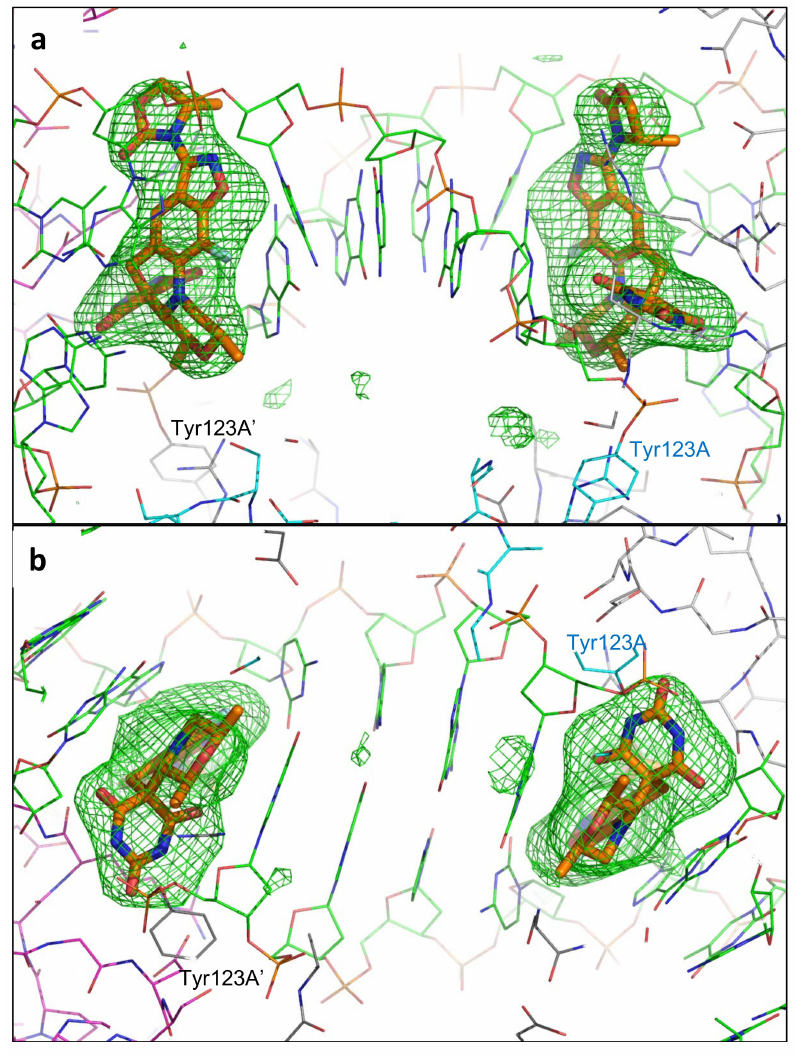
Figure 2. Final Fo-Fc omit map (+3 sigma) for the two zoliflodacins: orthogonal (90 ◦ ) views . A final Fo-Fc omit map was calculated by omitting the two zoliflodacins from the coordinates, which was refined with refmac [43]. The initial omit maps calculated from 5cdm coordinates were of similar quality but showed some additional density around the novel five-membered ring (top ( a )). The zoliflodacins are shown as sticks with orange carbon atoms; gyrA has cyan or grey carbons, gyrB has magenta or grey carbons, and the DNA has green carbons (water molecules are not shown for clarity). The pyrimidinetrione rings are clearly seen in the view in panel ( b